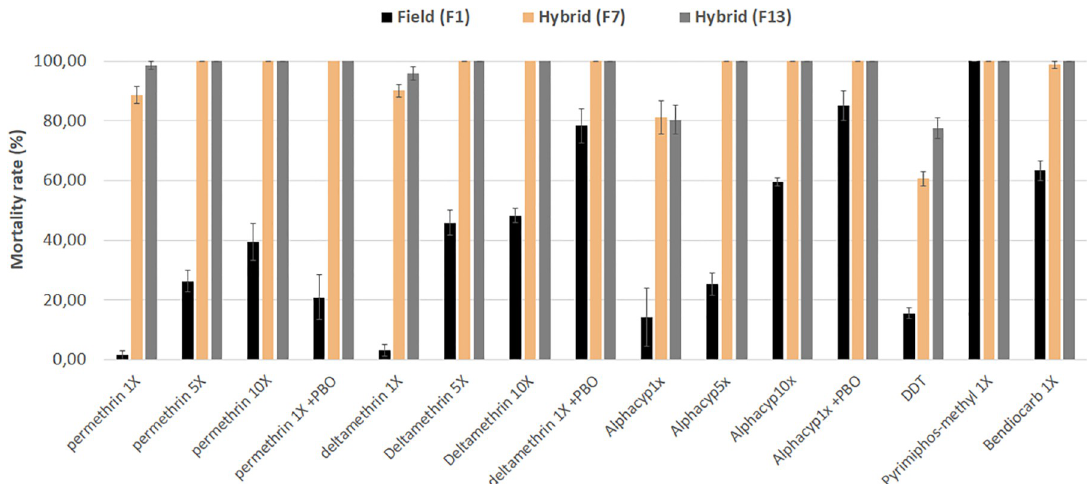
Fig 6. Evaluation of the restoration of susceptibility in the hybrid colony MYG/KIS. Determination of susceptibility to all the four classes of insecticides, resistance intensity with 5 × and 10 × the diagnostic concentrations of pyrethroids and effect of pre-exposure to synergist PBO against pyrethroids type I and type II in comparison with field F0. Results are average of percentage mortalities from four replicates each ± SEM.